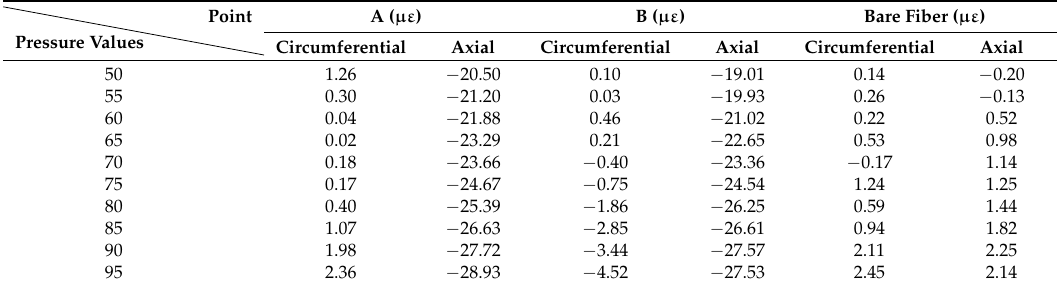
Table 1. The absolute error of strain for Points A and B in the circumferential and axial direction.